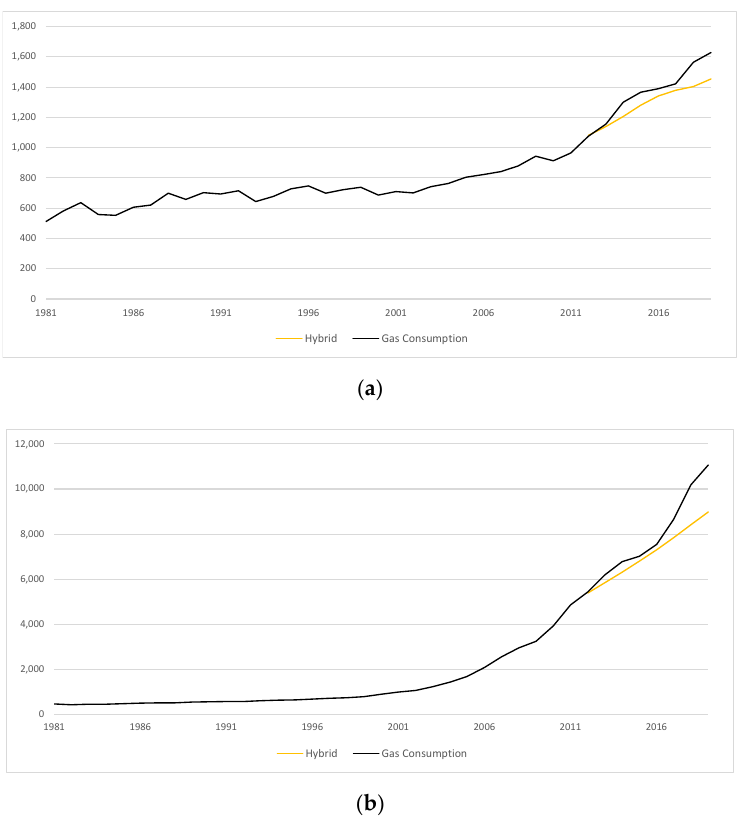
Figure 3. Natural gas consumption [TJ]–actual values and forecasts: ( a ) Algeria; ( b ) China.